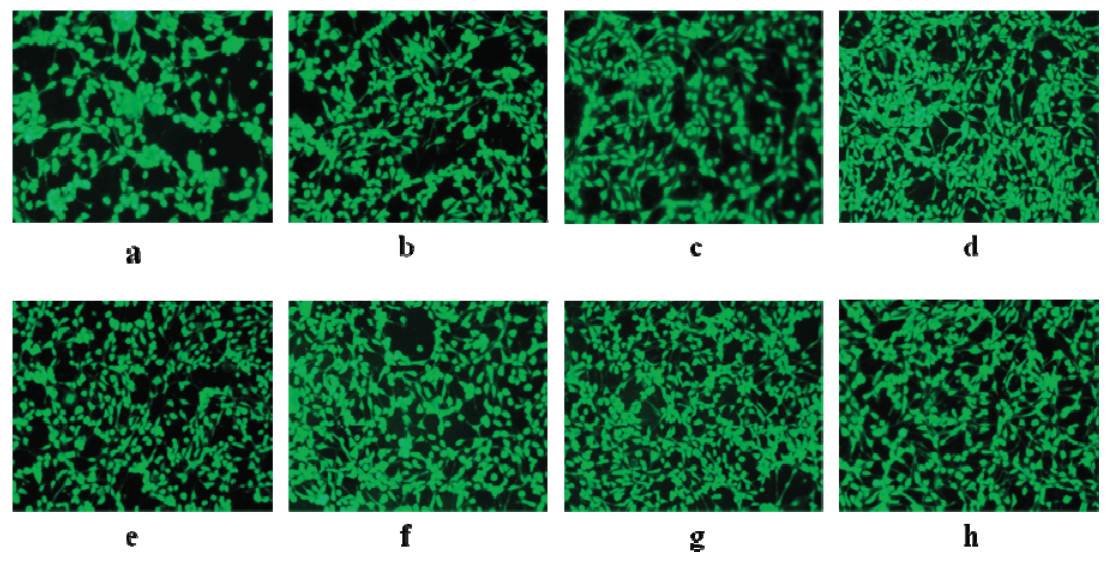
Figure 9. Fluorescent microscopy images of NIH/3T3 cells grown on PLH polymers. ( a ) PLA; ( b ) PLH9.3; ( c ) PLH7.8; ( d ) PLH7.0; ( e ) PLH6.3; ( f ) PLH6.1; ( g ) PLH5.0; and ( h )